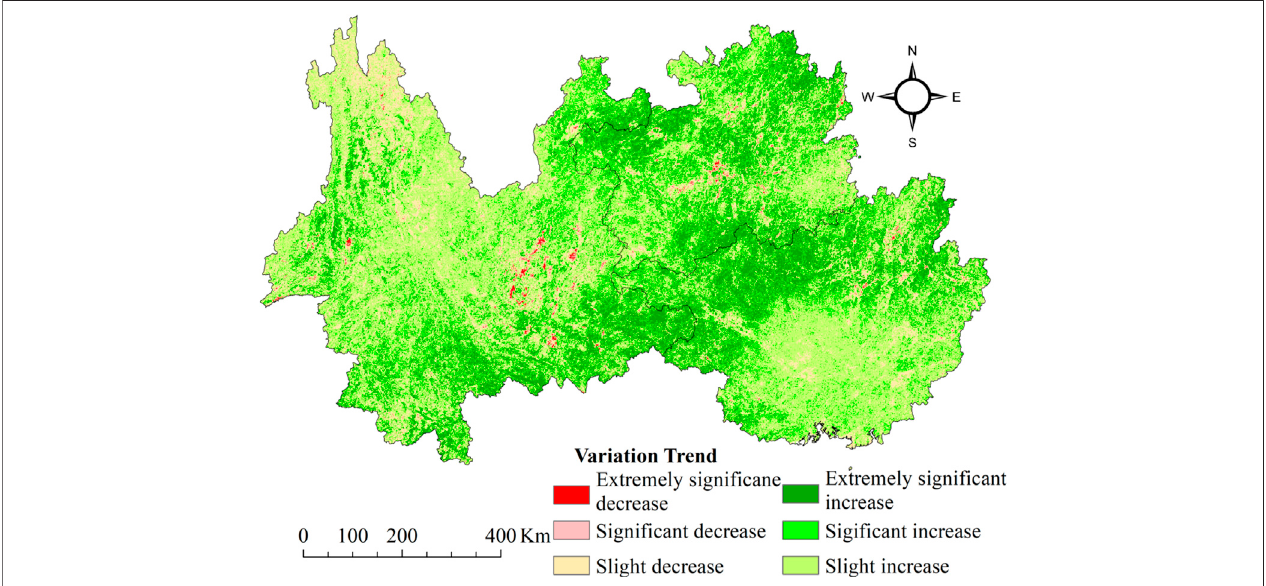
FIGURE 10 | Variation trend of residual NDVI in the three karst provinces of southwest China from 2001 to 2019.